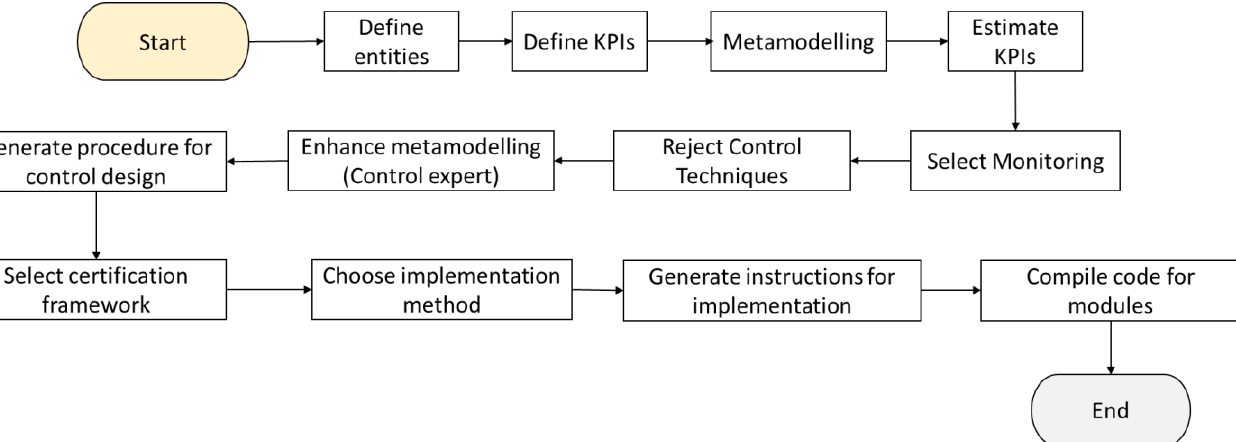
Figure 11. Updated workflow for process monitoring/control taking into account metamodelling.